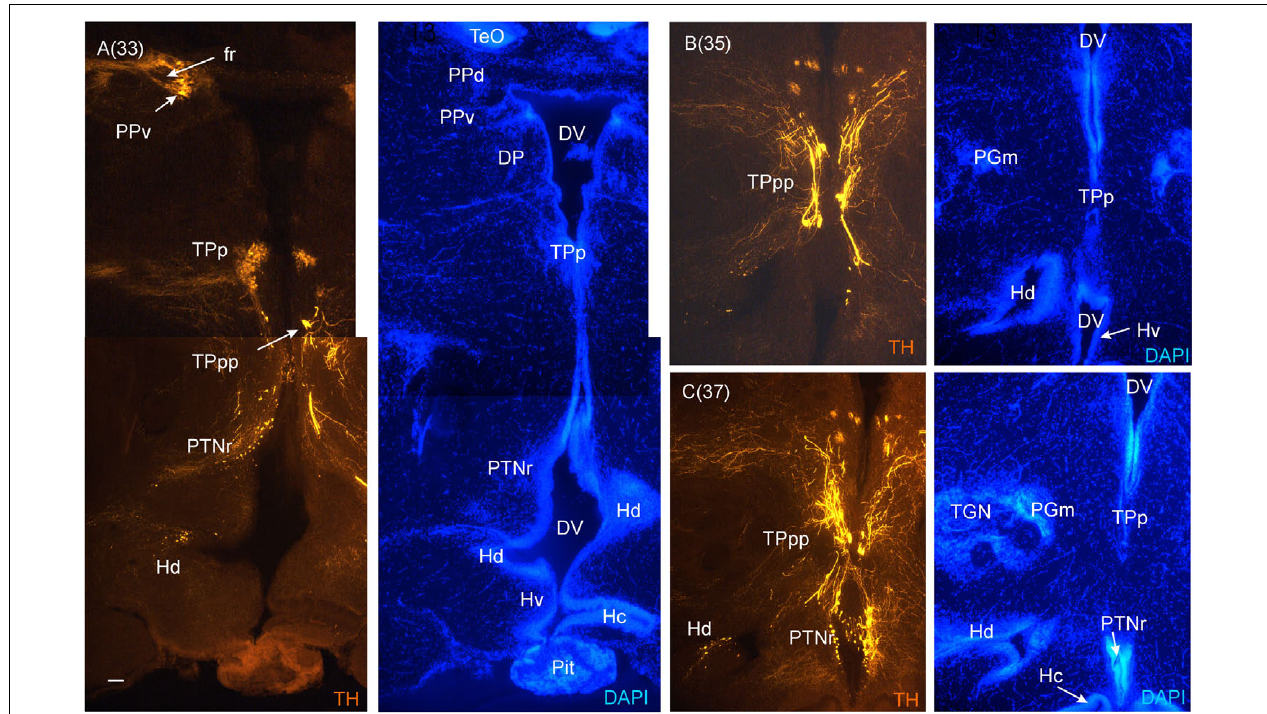
FIGURE 7 | Consecutive most caudal transverse sections of the archerfish diencephalon immunostained for tyrosine hydroxylase (TH) with accompanying nuclear (DAPI) counterstain. At this caudal level, the periventricular posterior tubercular nucleus (TPp) exhibits in addition to small round cells, larger pear-shaped cells (A–C) . The pretectal (PPd/PPv) and dorsal hypothalamic (Hd) dopamine cells are still present and the posterior tuberal nucleus comes up (PTNr seen in A–C ) which also exhibits dopamine cells. Note the absence of TH label in the caudal periventricular hypothalamic zone (Hc). However, see text for the likely expression of the th2 gene whose enzyme product is not visualized by common antibodies against TH (Yamamoto et al., 2010, 2011). Arabic numerals in brackets indicate the relative distance of sections. Scale bar in (A) : 0.1 mm (applies to all panels). See abbreviation list and text for